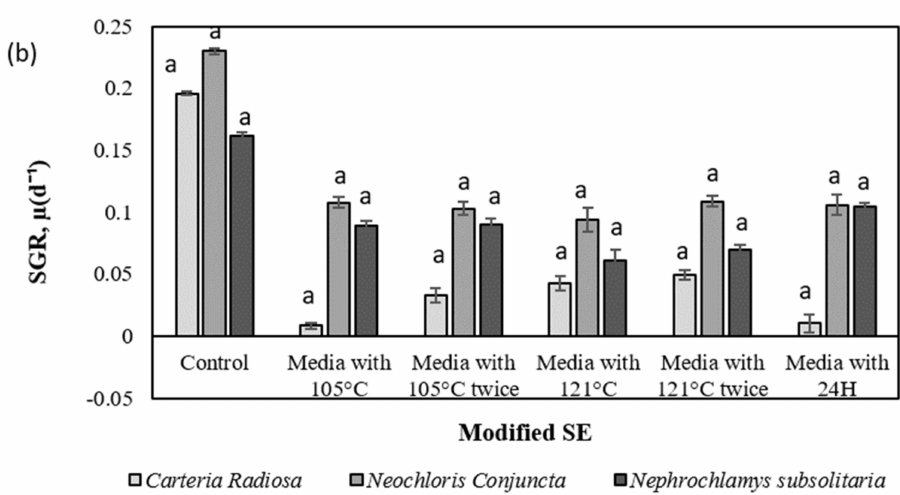
Figure 6. Specific growth rate, µ , of C. radiosa, N. conjuncta , and N. subsolitaria, in control (media without soil extract), media with 105 ◦ C, media with 105 ◦ C twice, media with 121 ◦ C, media with 121 ◦ C twice and media with 24 h at ( a ) RMFR SE and ( b ) AHFR SE. (media with 105 ◦ C- autoclave 105 ◦ C; media with 105 ◦ C twice—autoclave 105 ◦ C 2 × after natural extraction 24 h; media with 121 ◦ C- autoclave 121 ◦ C after natural extraction 24 h; media with 121 ◦ C × 2- autoclave 121 ◦ C twice after natural extraction 24 h; media with 24 h- natural extraction for 24 h). The error bars ( n = 3) represent the standard deviation. a The overall mean of the same row with distinct superscripts change significantly ( p < 0.05) using ANOVA and Tukey post